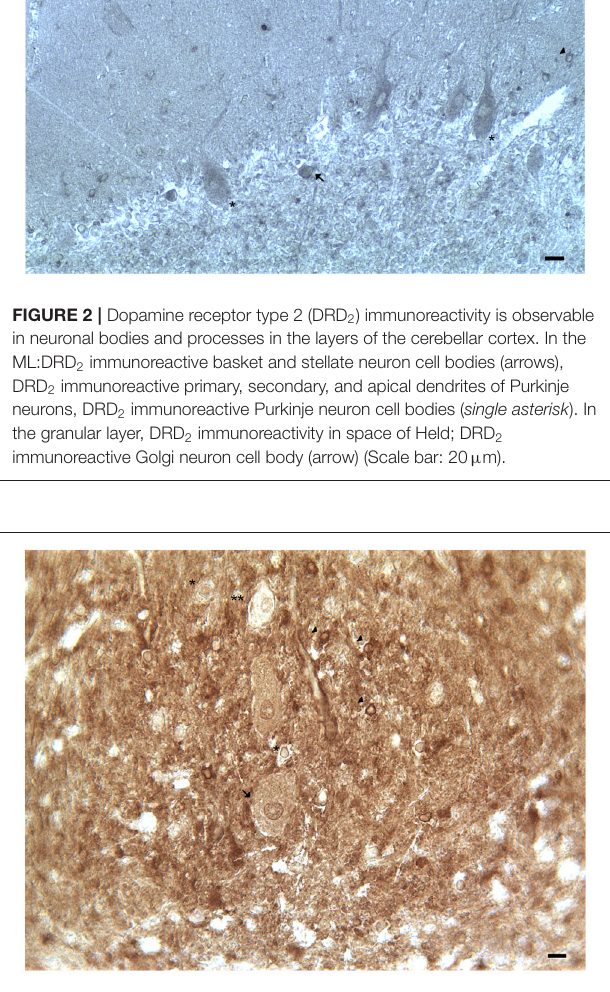
FIGURE 3 | Dopamine transporter (DAT) immunoreactivity in the dentate nucleus. The dopamine transporter (DAT) immunoreactivity is detectable in the dentate nucleus gray substance and in the neighboring white substance. DAT immunoreactive small neuron cell bodies ( arrowheads ); DAT immunonegative small neuron cell body ( single asterisks ) DAT immunoreactive cell body of projective neuron type, central neuron ( arrow ); fine clusters of DAT immunoreactivity in the neuropil of the nucleus and in the neighboring withe substance (Scale bar: 15 µ m).